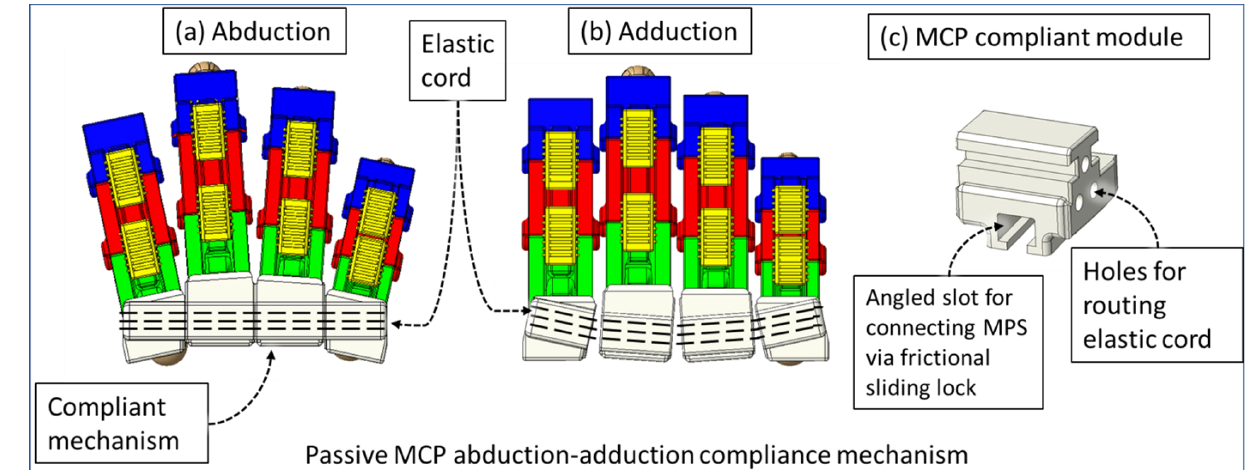
Figure 7. Novel compliant mechanism.